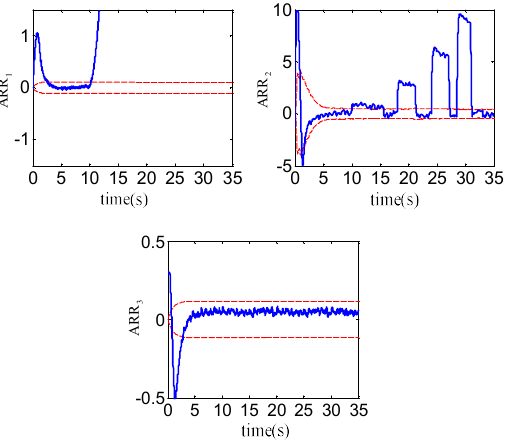
Figure 8. Residual responses of experiment. Table 4. Comparison of fault estimation performance.